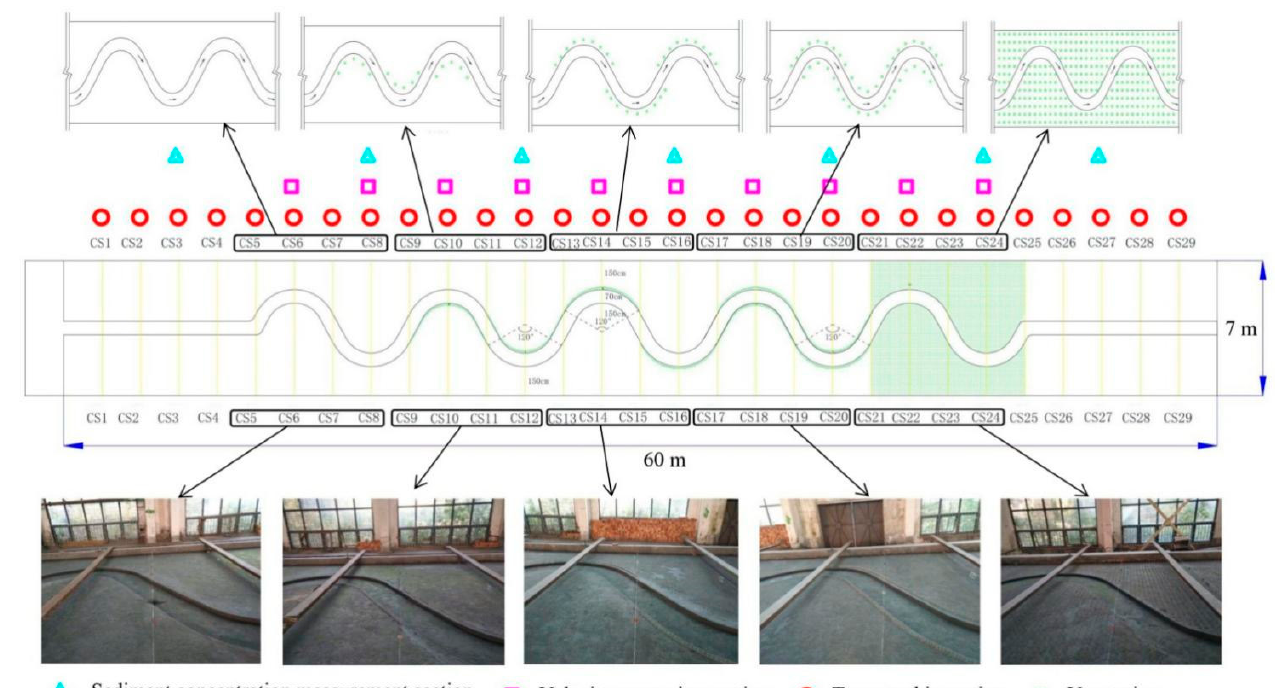
Figure 2. Experimental design. (CS5–CS8, curved compound channel with non-vegetation on the beach; CS9–CS12, curved compound channel with vegetation on the convex bank of the beach; CS13–CS16, curved compound channel with vegetation on the concave bank of the beach; CS17–CS20, curved compound channel with vegetation on both sides of the beach; and CS21–CS24, curved compound channel full of vegetation on the beach).